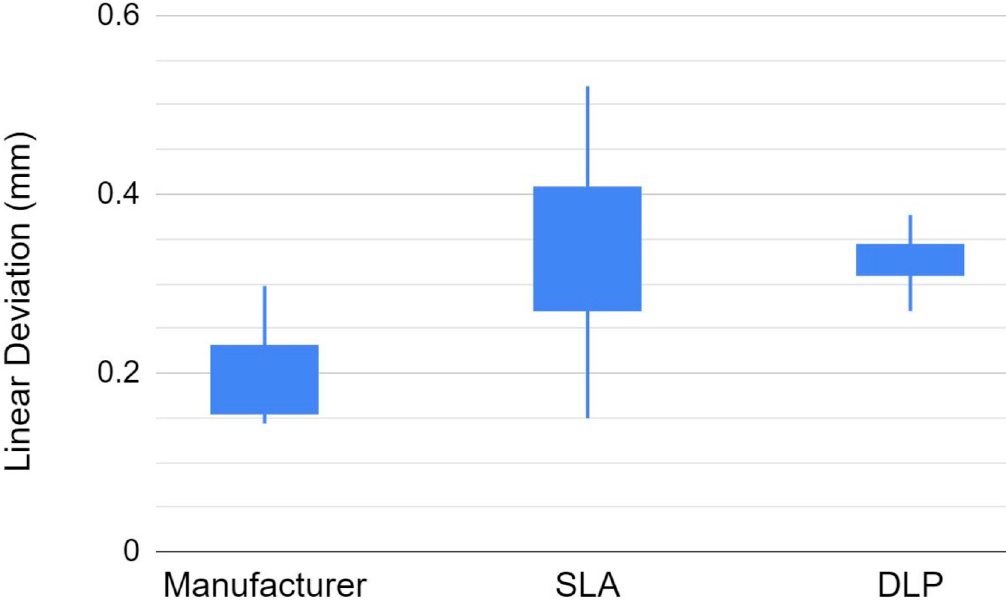
Fig 7. Linear deviations (mm) of the manufacturer’s scan bodies (control), the SLA and DLP printed scan